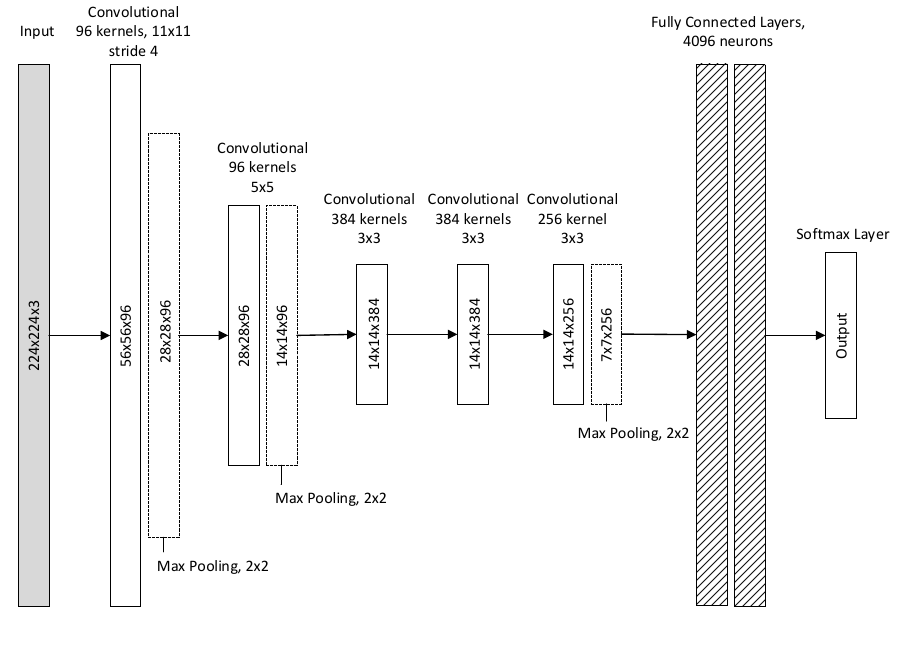
Figure 1. AlexNet